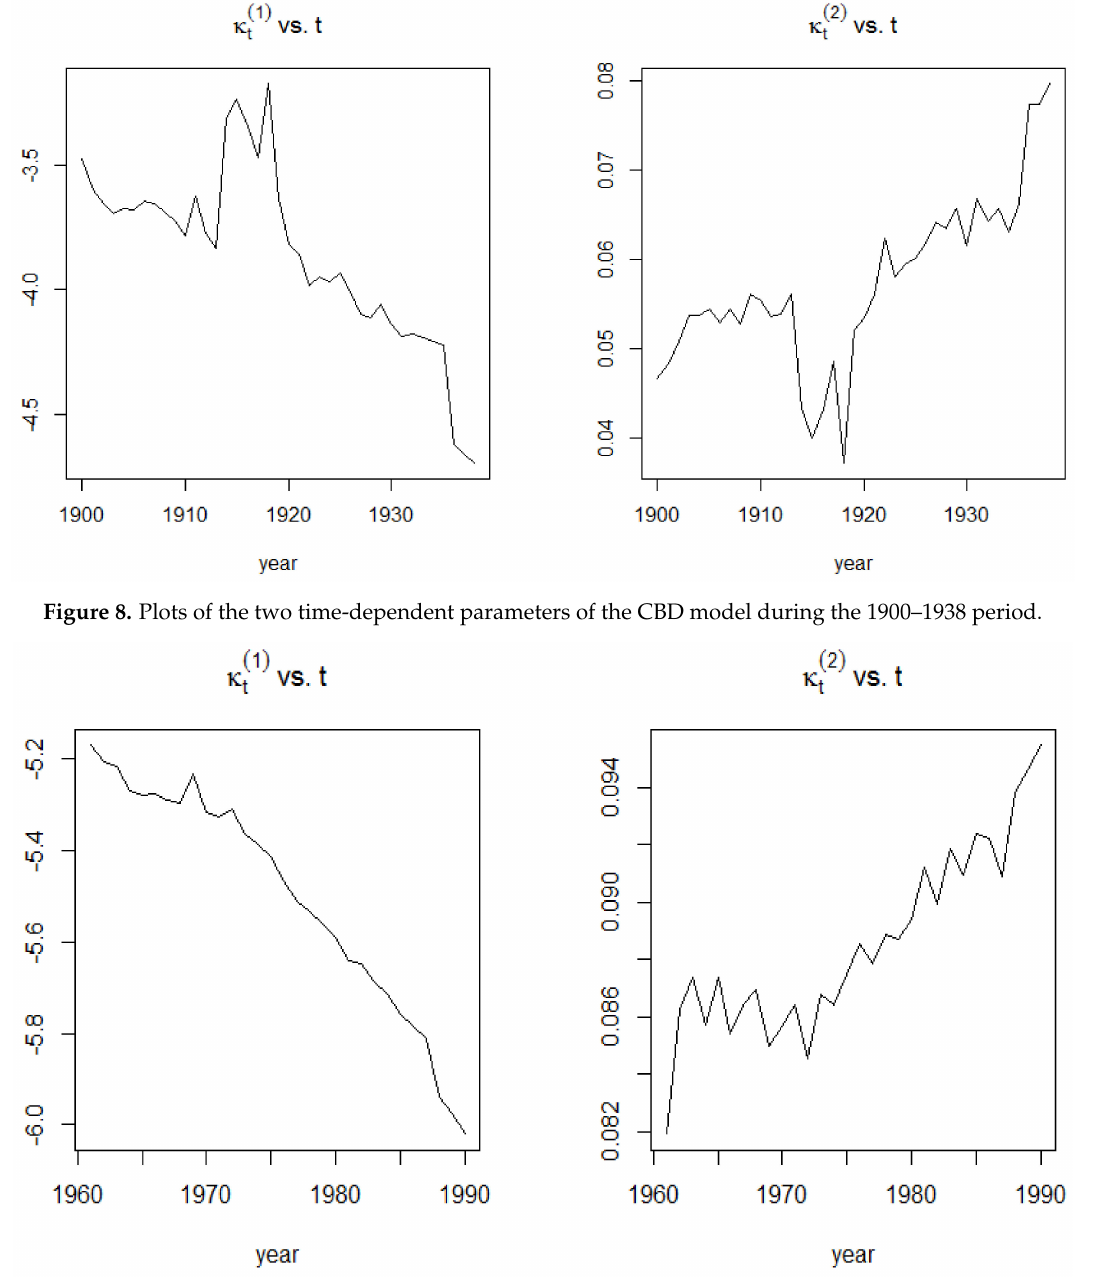
Figure 9. Plots of the two time-dependent parameters of the CBD model during the 1961–1990